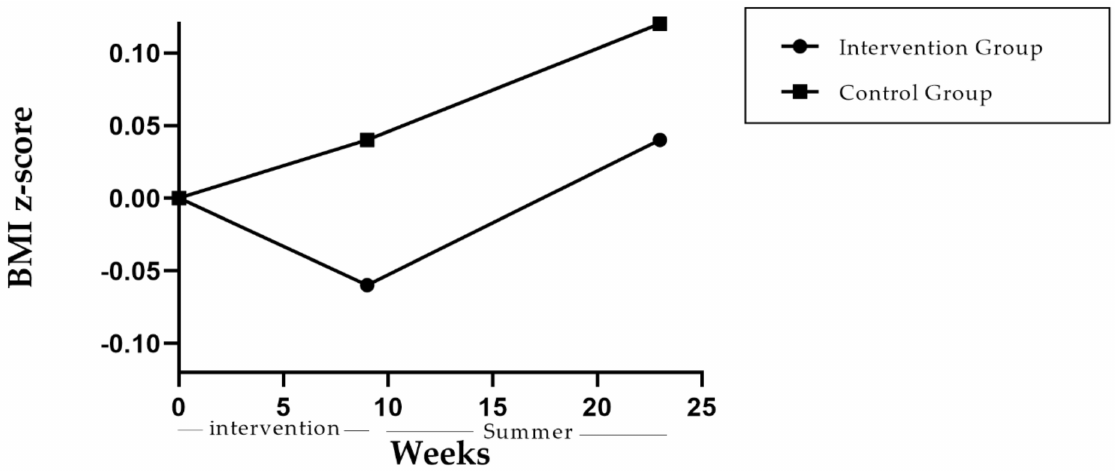
Figure 2. Change in BMI z-score at 9 and 23 weeks of